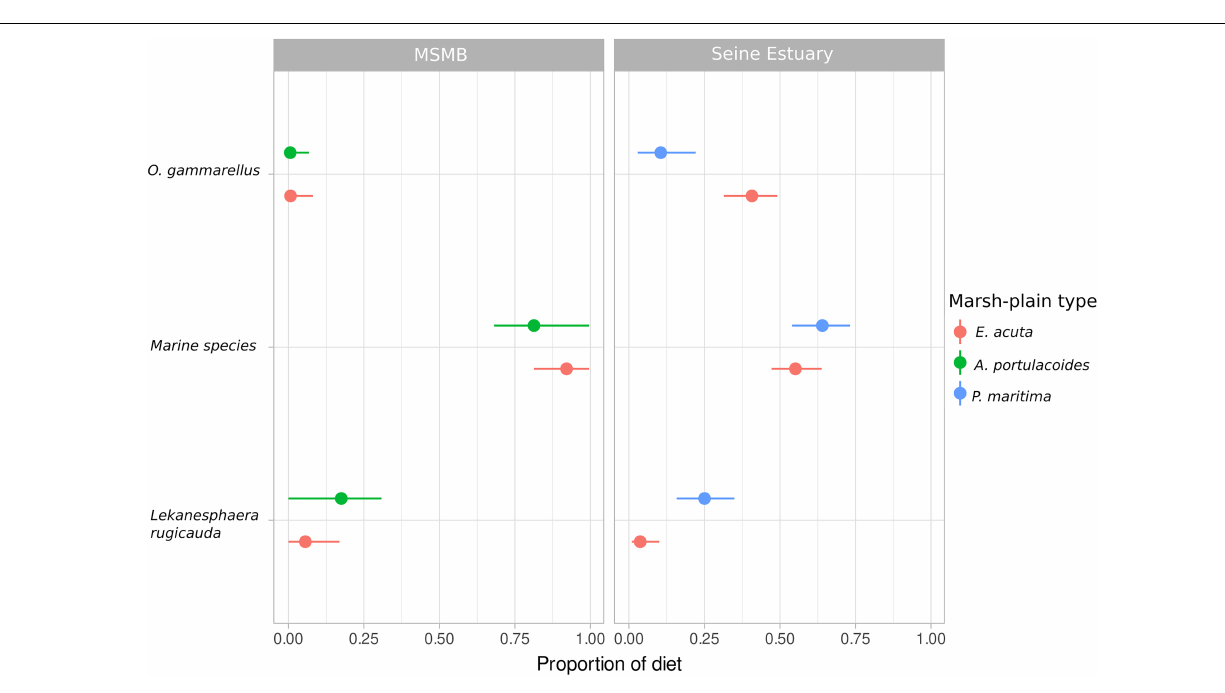
FIGURE 4 | Posterior median (points) with 90% (horizontal lines) confidence intervals for the contribution of each prey according to marsh-plain type in the sampling area for Dicentrarchus labrax . MSMB, Mont-Saint-Michel Bay. Marine species refers to the group: Carcinus maenas , Mysida sp. , Palaemonetes varians , and Hediste diversicolor